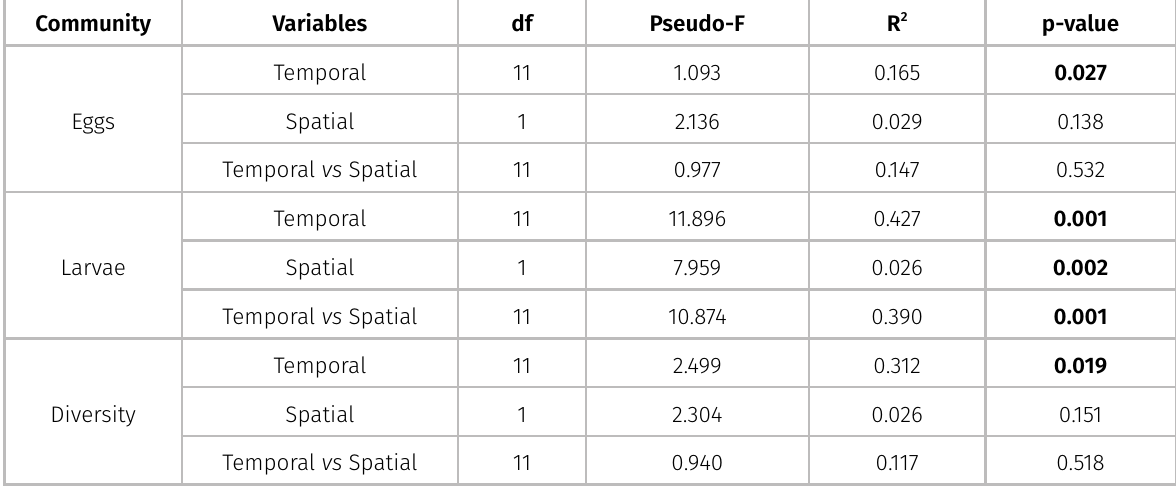
Table II. Summary of the two-way PERMANOVA on the spatial and temporal effects on the density of fish eggs and larvae and on the diversity of species in Lake Juá at the mouth of the Tapajós River, state of Pará, Brazil. Values in bold represent a significant difference. df: degree of freedom. Pseudo-F: pseudo-F statistics. R 2 : R squared.